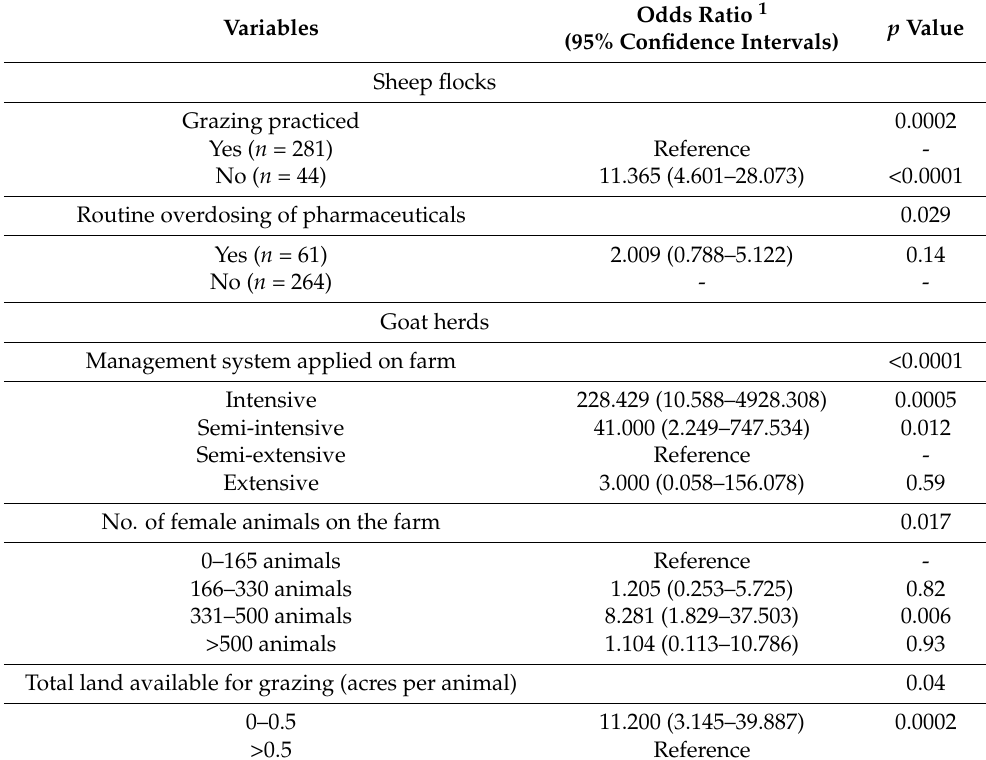
Table 6. Results of multivariable analysis for the presence of Cryptosporidium in faecal samples from ewes and does in 325 sheep flocks and 119 goat herds,